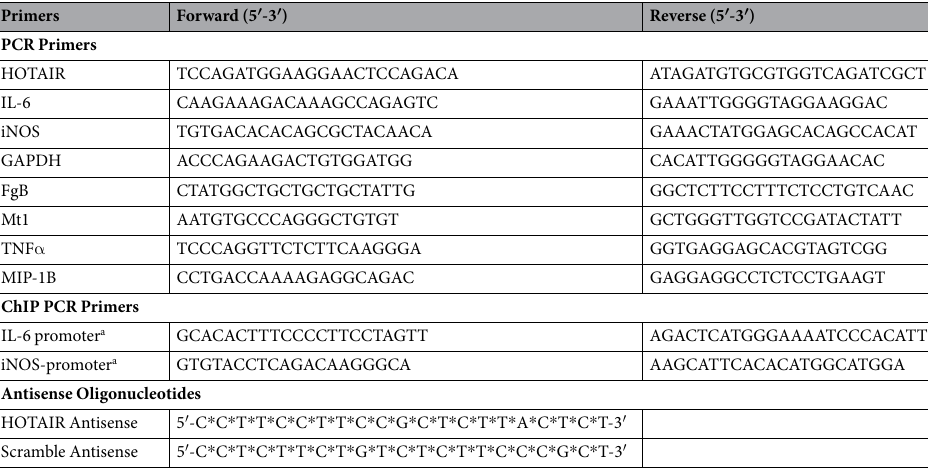
Table 1. Sequences of primers and antisense oligonucleotides. a ChIP PCR primers are flanked around